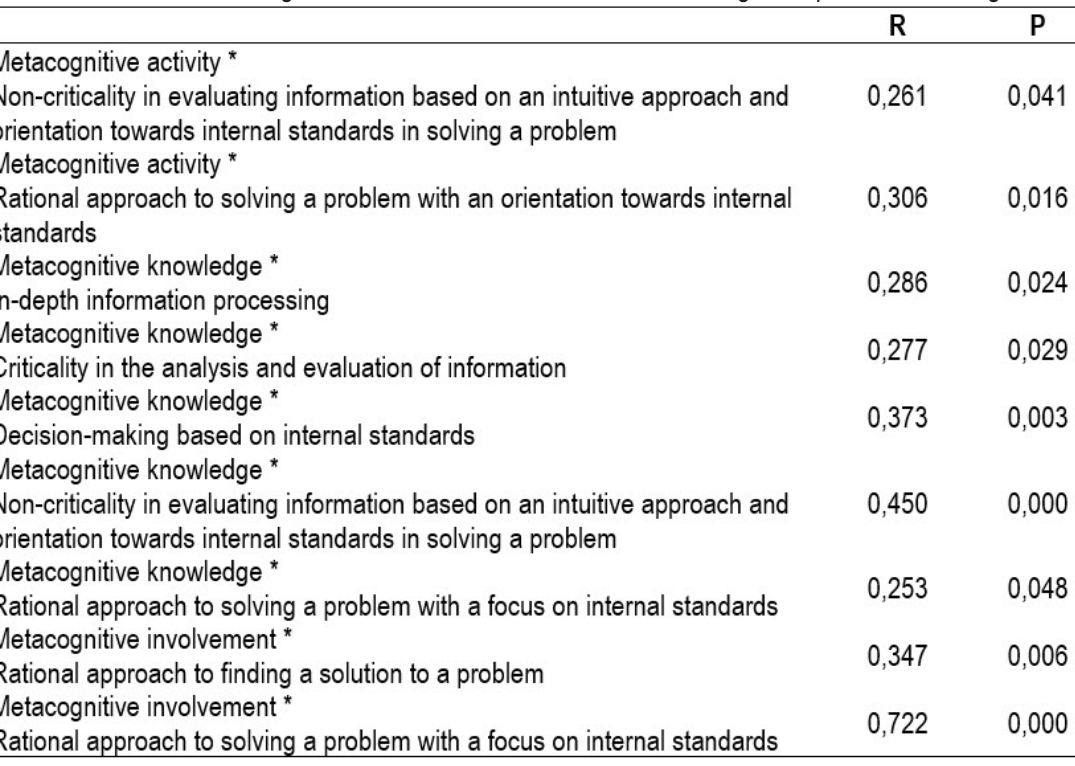
The results of the correlation analysis with the use of Spearmen’s correlation coefficient on the connection between metacognitive characteristics and reflective strategies of problems